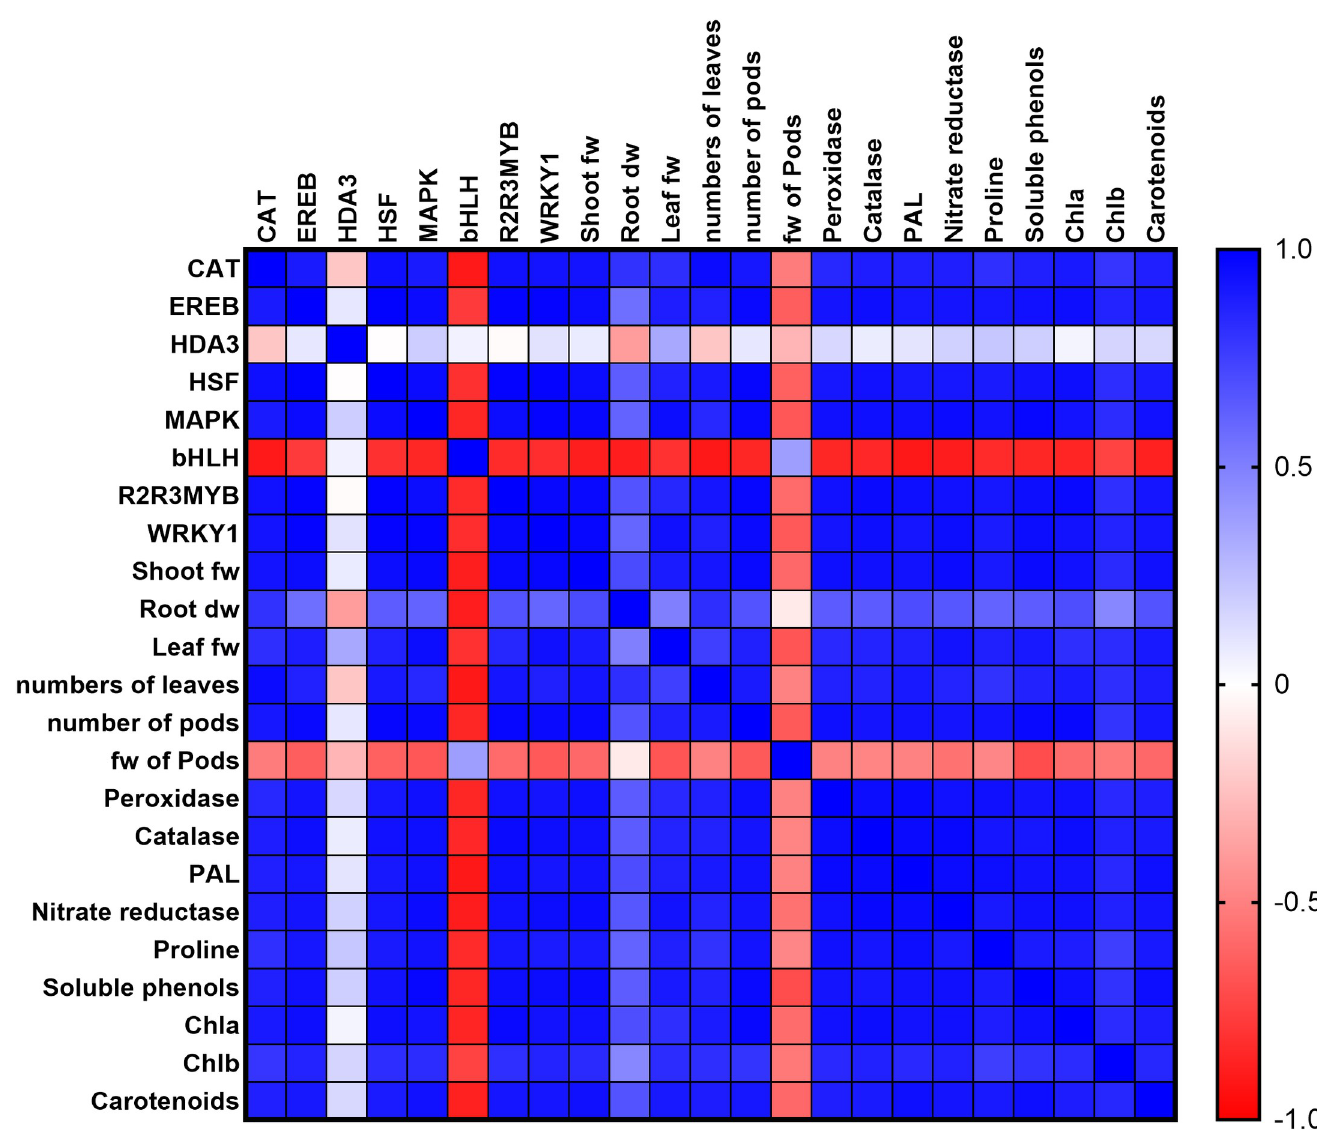
Fig 4. Heatmap correlation matrix among molecular and physiological traits